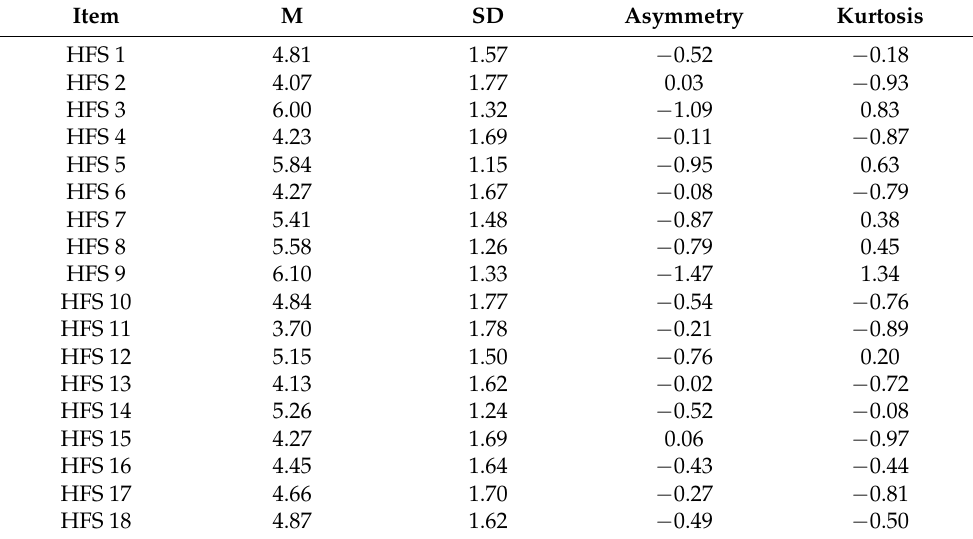
Table 1. Heartland Forgiveness Scale (HFS) descriptive statistics in the pilot study ( n = 203).